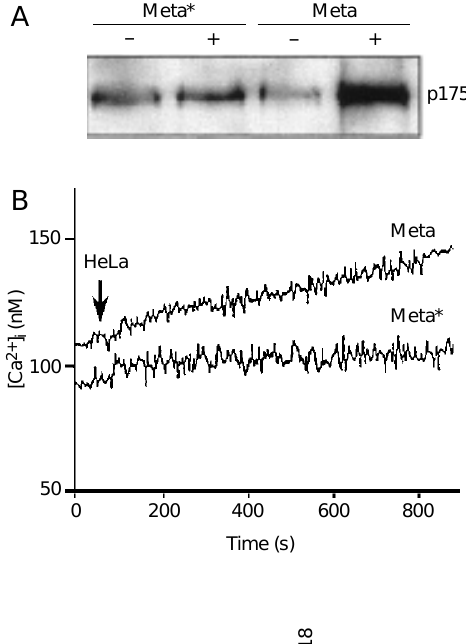
Figure 3 - Involvement of the T. cruzi metacyclic trypomastigote surface molecule gp82 with p175 tyrosine phosphorylation and Ca 2+ response. A , Parasites were incubated in the absence (-) or in the presence of HeLa cell extract, unmixed (+HeLa) or mixed with recombinant protein J18 which contains the full- length gp82 sequence (+HeLa/ J18), or were incubated with a monoclonal antibody directed at gp82 (+3F6). After 20 min at 37 o C, the parasites were pro- cessed for anti-phosphotyrosine immunoblotting. B , HeLa cell ex- tract, mixed or not with J18, or monoclonal antibody 3F6 was added at the indicated time (ar- row) to fura-2-loaded metacyclic trypomastigotes and [Ca 2+ ] i was